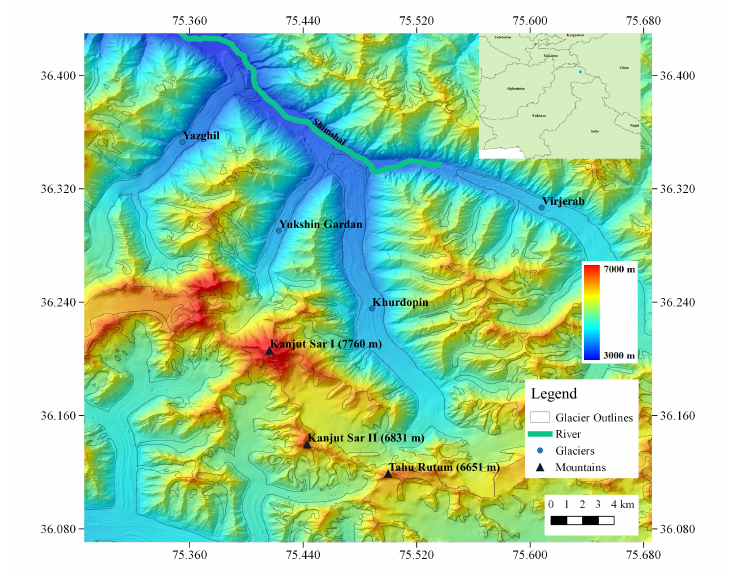
Figure 5. Color hypsometric ALOS DEM of Khurdopin glacier and the surrounding